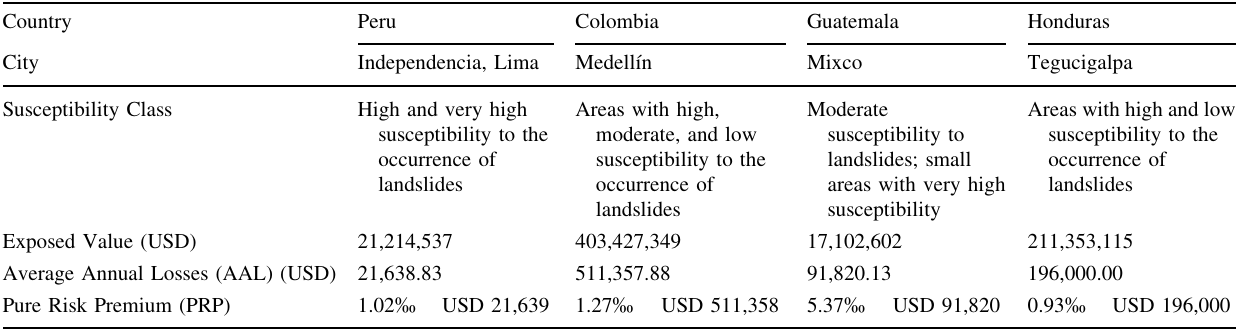
Table 5 Catastrophe risk assessment and pure risk premium costs—landslides. Source : Adapted from Cardona (2018a)